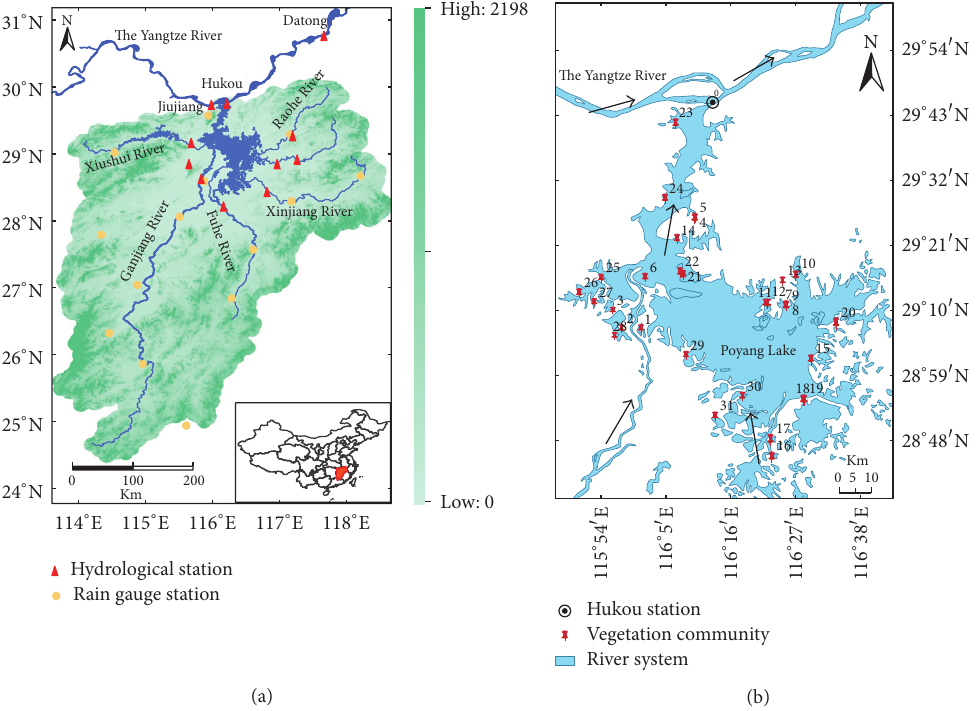
Figure 1: Location of the Poyang Lake river basin (a) and concerned distribution of the vegetation chart